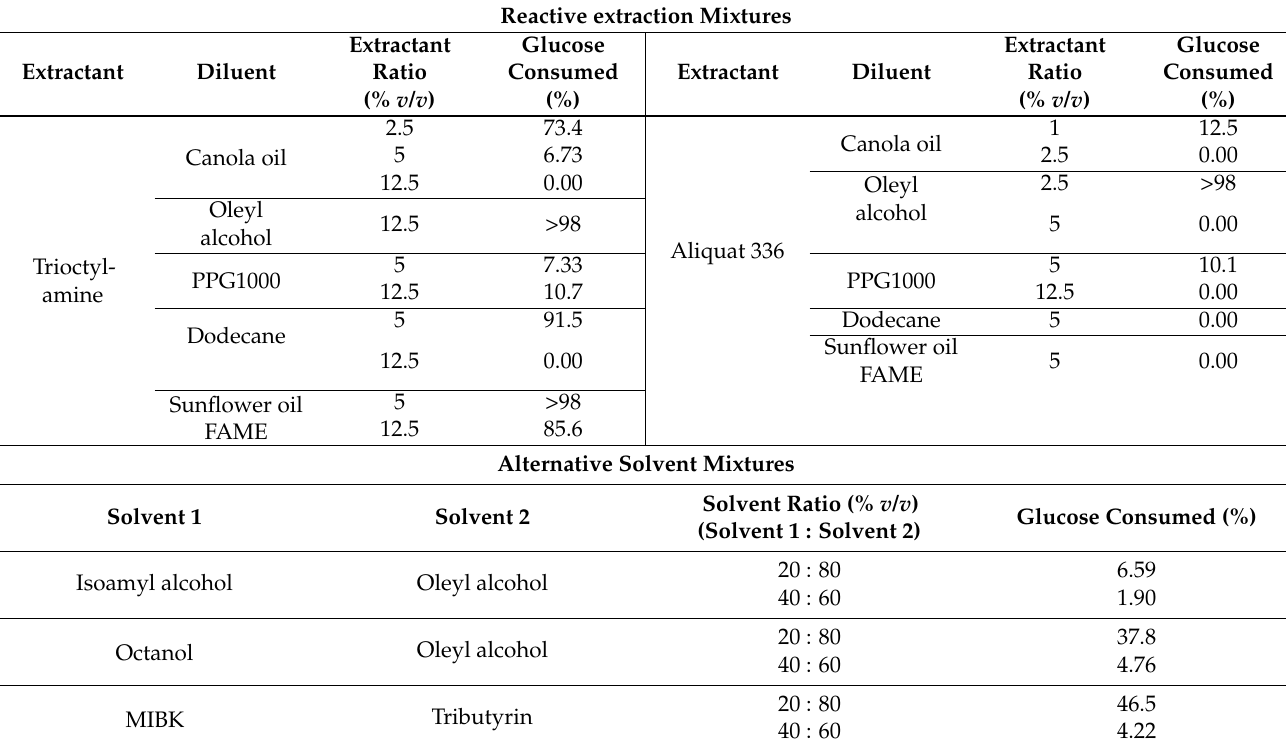
Table 2. Cont. Reactive extraction Mixtures